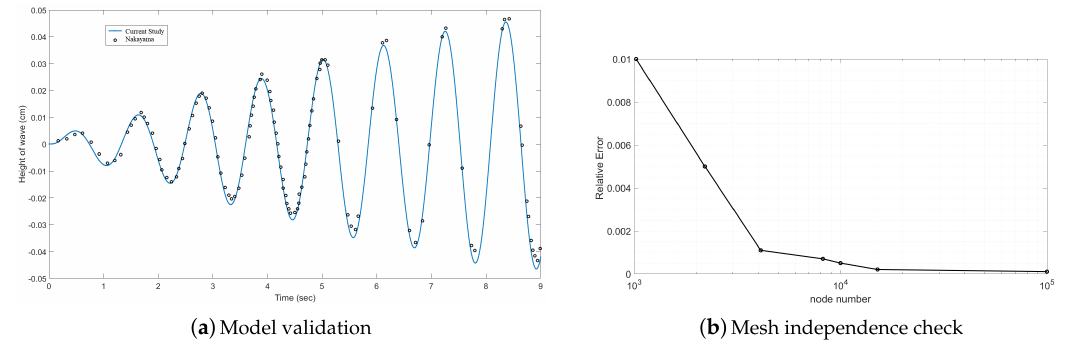
Figure 2. Validation of simulation.